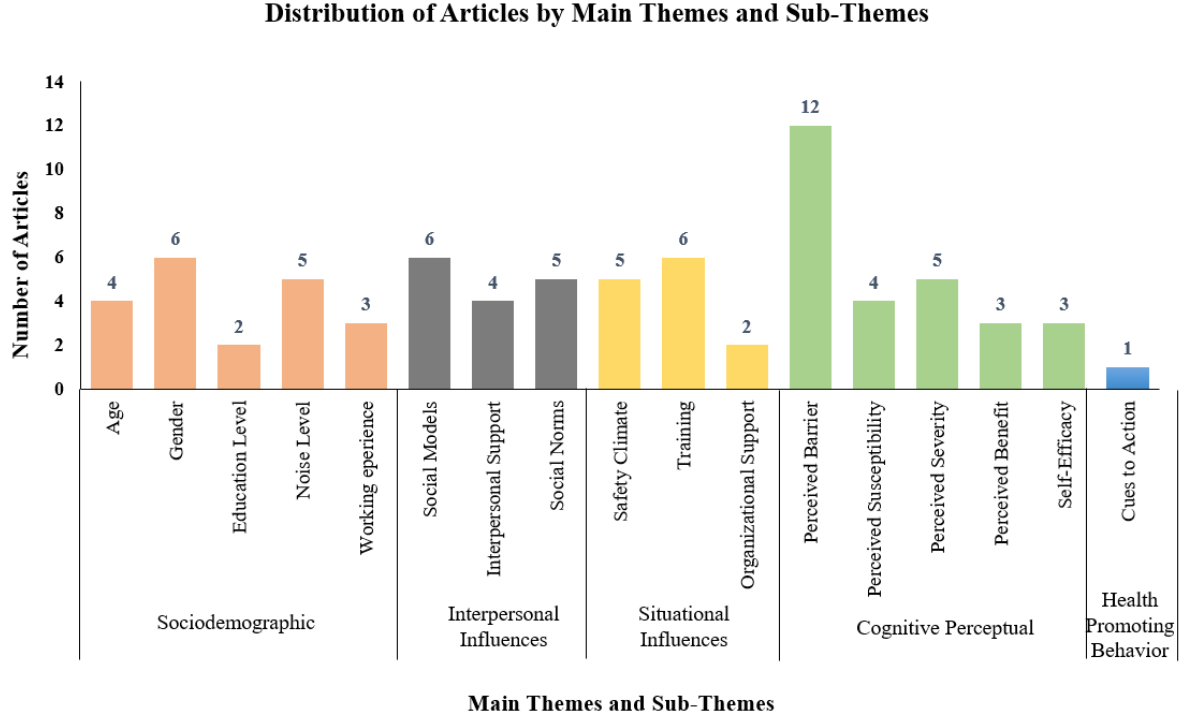
Figure 3. Distribution of articles by main themes and sub-themes in the SLR study (databases accessed were Scopus, Web of Science (WOS), ScienceDirect, PubMed, Wiley Online Library, and Google Scholar) between 2006 and 2021.